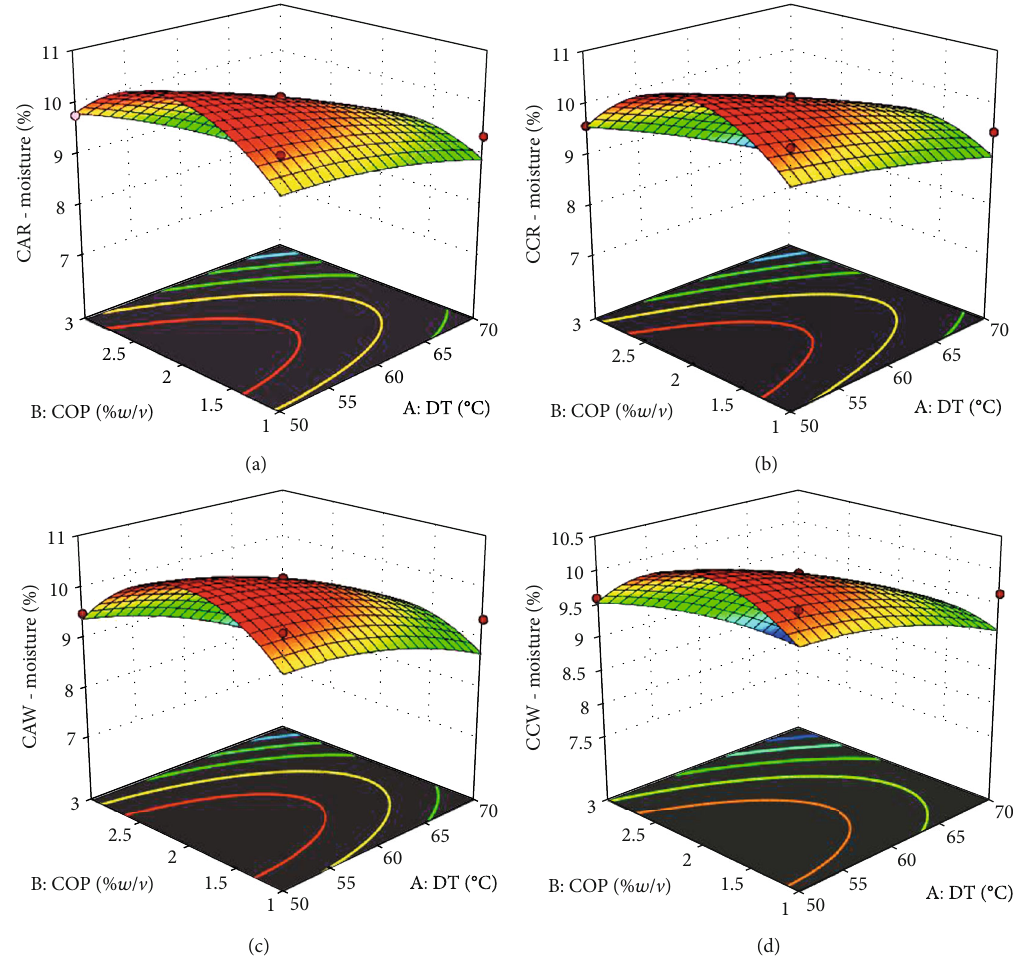
Figure 3: Response surface plots for percentage moisture of cassava fl our. (a) Cassava from red landrace pretreated with citric acid. (b) Cassava from red landrace pretreated with calcium chloride. (c) Cassava from white landrace pretreated with citric acid. (d) Cassava from white landrace pretreated with calcium chloride. DT — drying temperature ( ° C); COP — concentration of pretreatment (% w / v